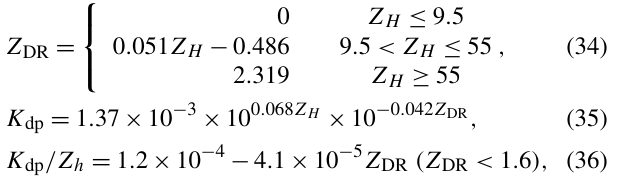
times below 0 ◦ km − 1 , such as areas of X of − 25 to − 20